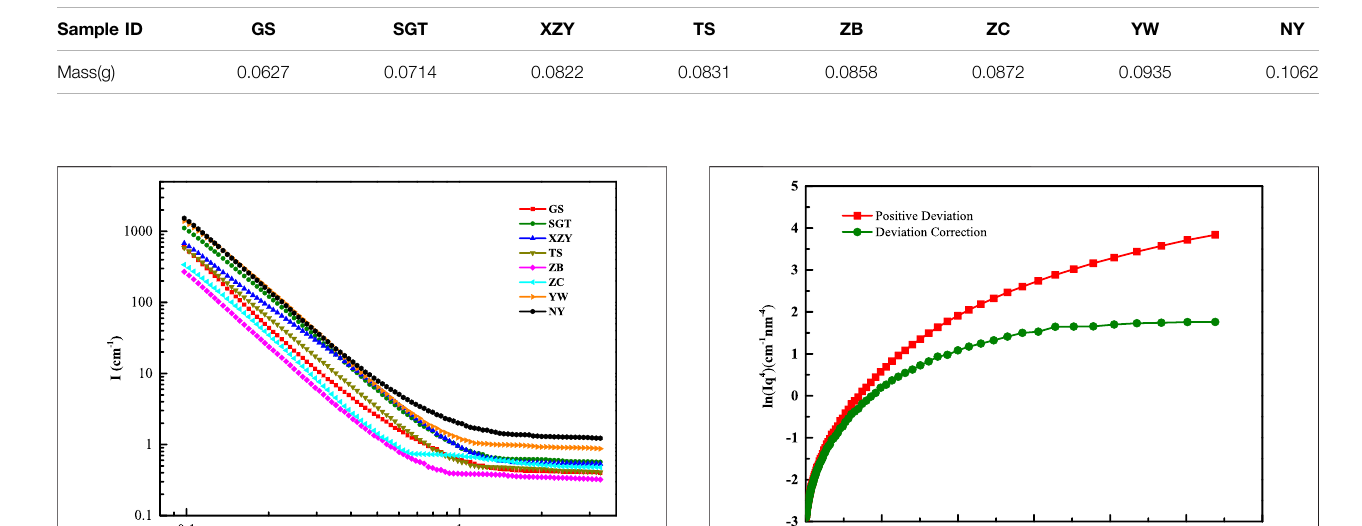
TABLE 3 | The mass of different experimental samples.